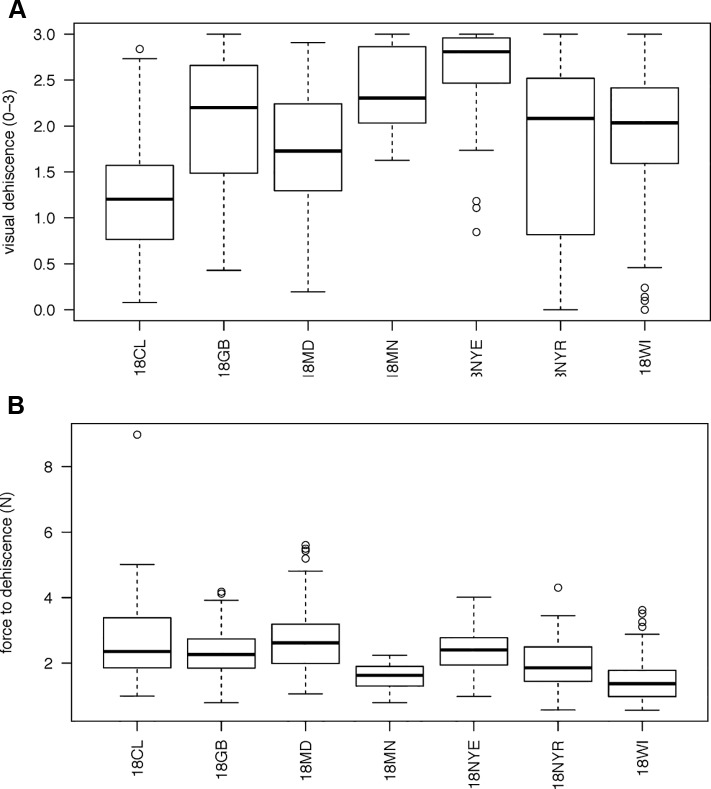
Boxplots of variation in vetch genotypes for (A) mean visual dehiscence (B) force necessary to cause dehiscence. Environments are listed as 18CL (Clayton, NC), 18GB (Goldsboro, NC), 18MD (Beltsville, MD), 18MN (St. Paul, MN), 18NYE (Ithaca, NY), 18NYR (Varna, NY), 18WI (Prairie Du Sac, WI). There is a strong outlier for force to dehiscence at 18CL. Visual dehiscence was scored on a 0–3 scale, with “0” indicating a pod fully intact pod (no openings along sutures), “1” indicating one suture was partially opened (one side of pod), “2” indicating two sutures were partially opened (both sides of pod), and “3” indicating that the pod had opened fully or partially.